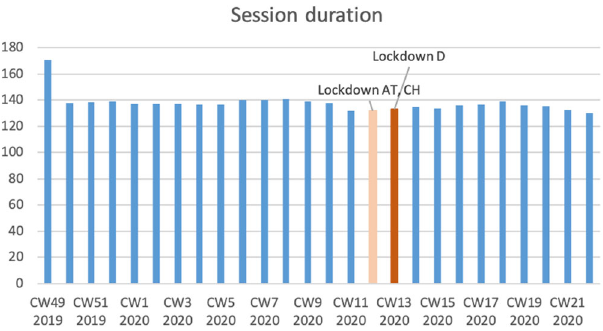
Fig. 1 Course of absolute page views over time (average per week). A decline in page views at the beginning of the lockdown can be seen, which is quickly relativized. CW = Calendar week, AT = Austria, CH = Switzerland, D = Germany.